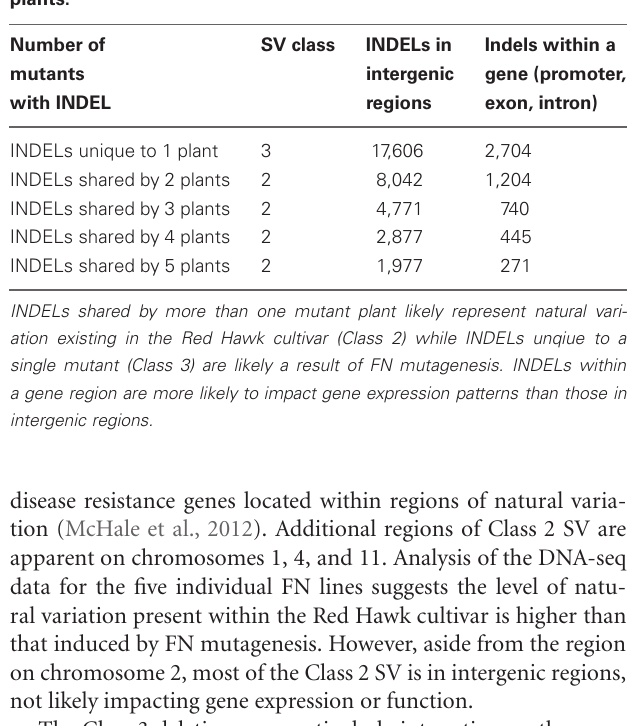
Table 5 | Identification and classification of INDELs in the five mutant